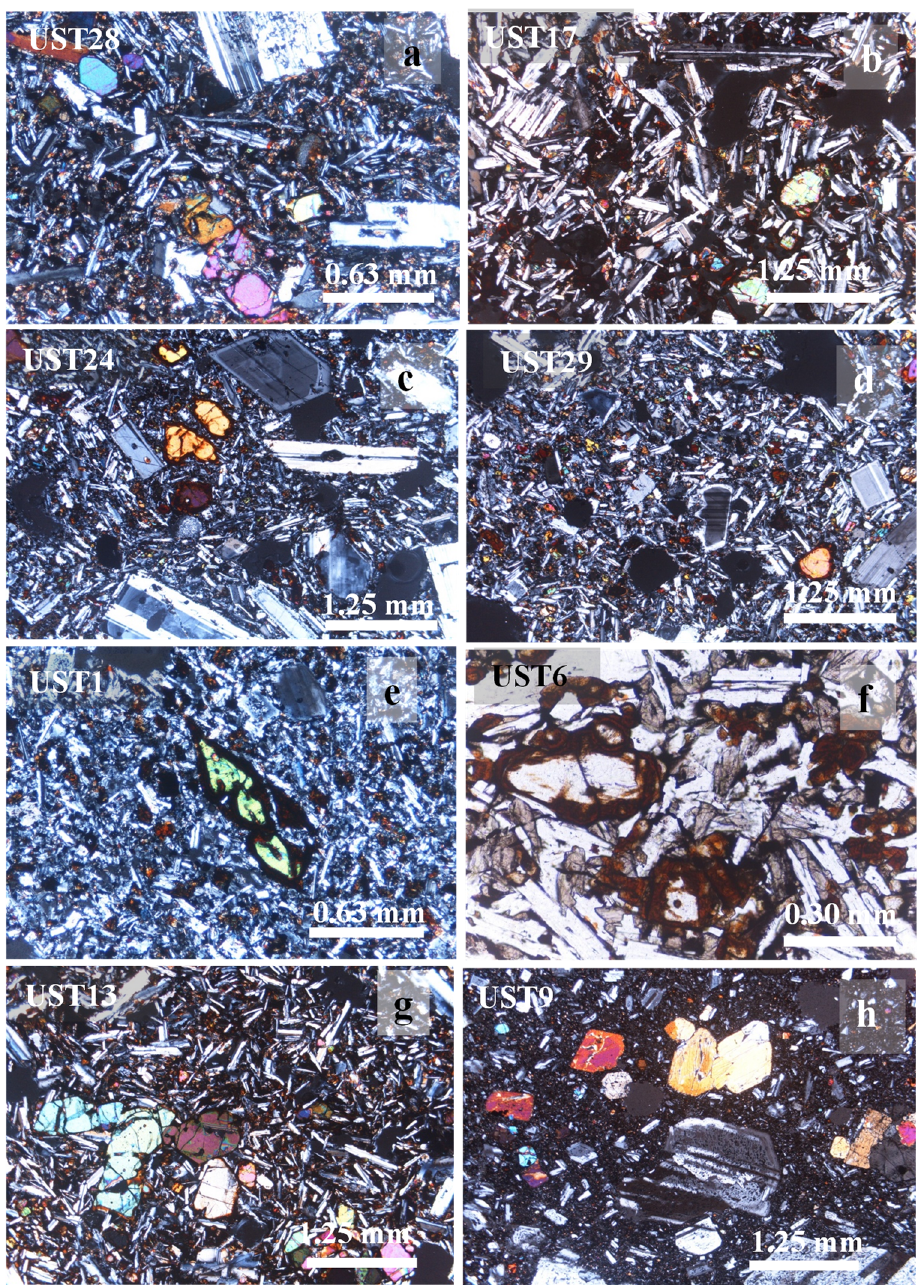
Figure 5. Thin section micrographs of the investigated volcanic millstones at the polarized light optical microscope (Plane Polarized Light, PPL or crossed nicols Polarized Light, XPL). ( a )—High-TiO 2 alkaline basalt (XPL); ( b , c )—basalts (XPL); ( d )—hawaiite (XPL); ( e )—mugearite (XPL) of the Na-Alkaline series; ( f , g )—tholeiitic / transitional basalts (PPL and XPL respectively); ( h )—Calcalkaline basaltic andesite (XPL).